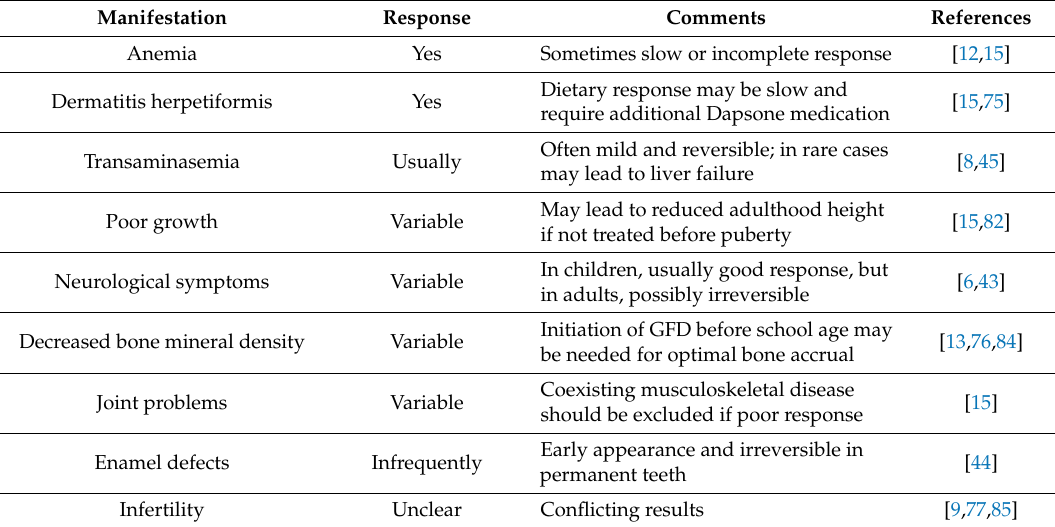
Table 2. Response of extraintestinal manifestations in celiac disease to a gluten-free diet